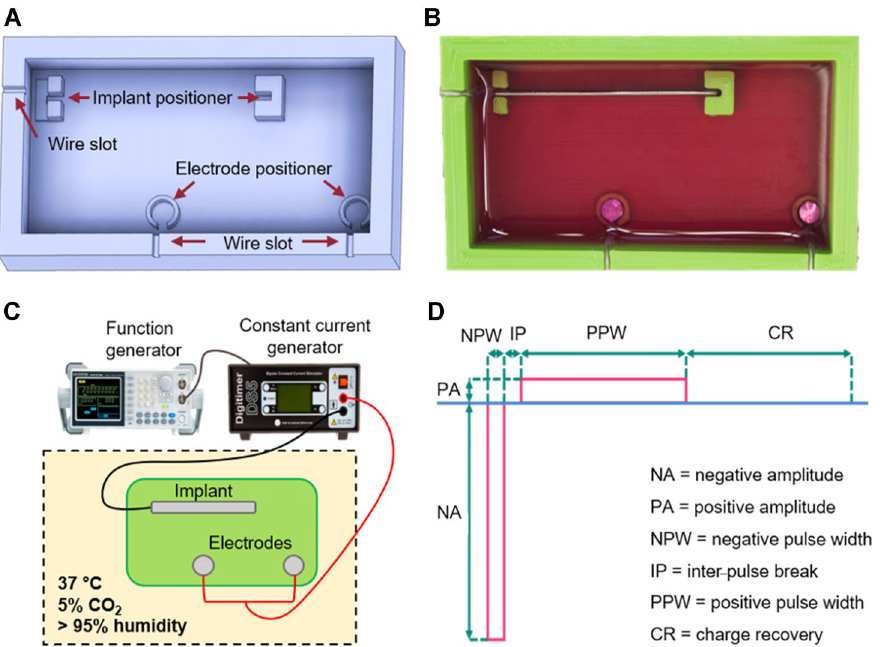
Figure 5. Experimental setup. ( A ) CAD sketch of the 3D-printed chamber where specific design features are indicated by arrows. ( B ) Photograph of the experimental setup during the experiments where the implant and electrodes are placed in their positioners and the chamber is filled with cell culture medium. ( C ) The experimental electrical circuit where the implant is the cathode while the electrodes function as anodes connected to the constant current generator, which in turn is connected to the function generator. ( D ) Pulse